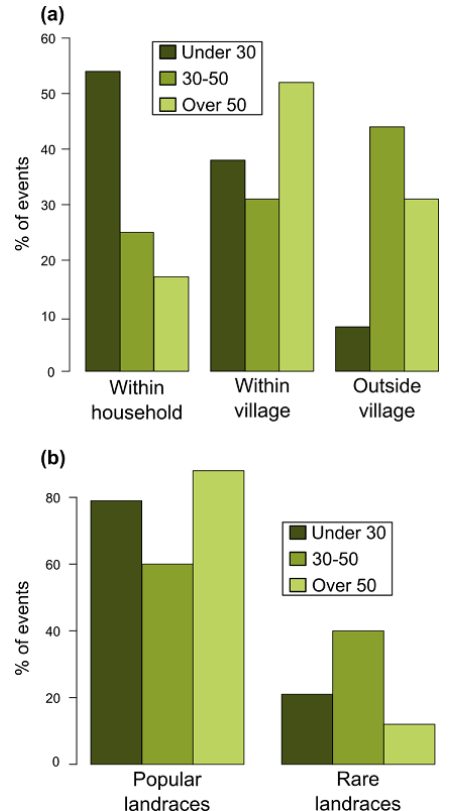
Fig. 3. Number of seed acquisition events based on age, seed source, and type of landrace. (a) Age and seed source (raked sample; Fisher’s exact test, P = 0.0034). (b) Age and type of landrace (raked sample; Pearson’s chi-square test, P =